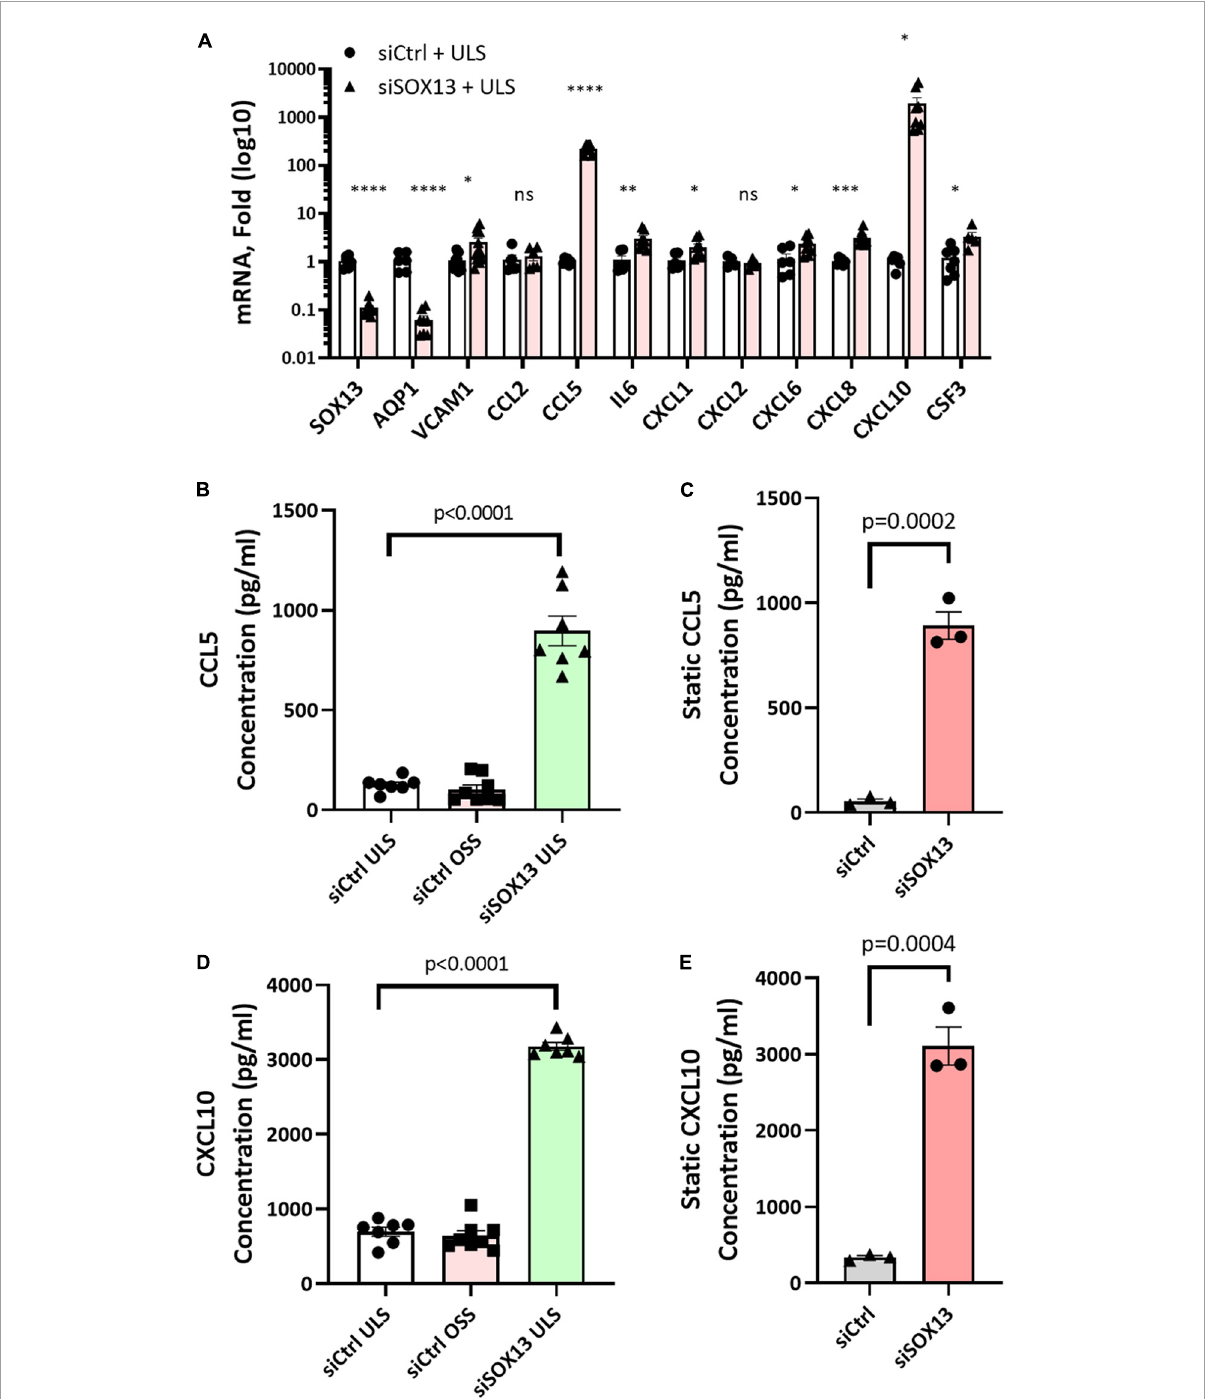
FIGURE6 Validation of SOX13 targets by qPCR and ELISA. HAECs treated with siSOX13 or siCtrl for 24 h were exposed to OSS or ULS for another 24 h, and total RNAs were analyzed by RNAseq to validate the top SOX13-dependent targets (A) n = 4–7, Mean ± SEM are shown. * p ≤ 0.05, ** p ≤ 0.01 *** p ≤ 0.001, and **** p ≤ 0.0001 as determined by student’s t -test. The conditioned media from HAECs treated with siSOX13 and shear (B,D) or static (C,E) conditions were analyzed by ELISA quantification of CCL5 (B,C) or CCL10 (D,E) . Mean ± SEM are shown, p -values determined by student’s t